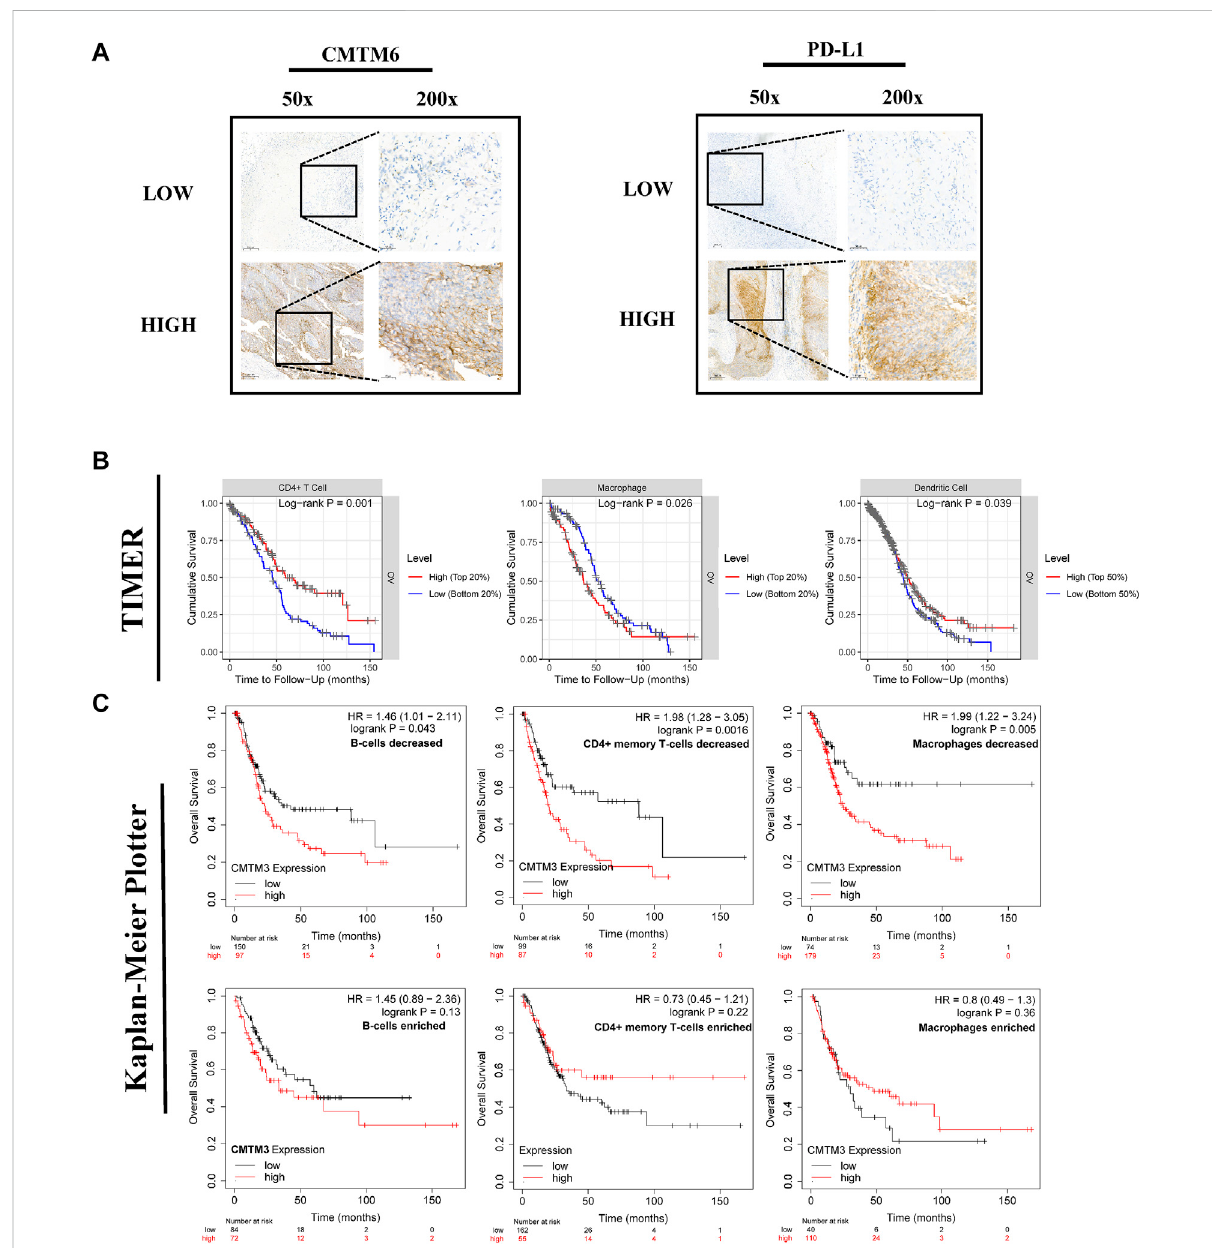
FIGURE 9 The immunohistochemical images of CD274 (PD-L1) and CMTM6, including 50x and 200x, respectively. The effect of CMTM3 expression level under different immune cell in fi ltration or different immune cell in fi ltration on the prognosis of patients with ovarian cancer. (A) The immunohistochemical images of CD274 (PD-L1) and CMTM6, including 50x and 200x, respectively. (HIGH represents the high-expression group of the CMTM6 gene; LOW represents the low-expression group of the CMTM gene) (B) Survival curves of different levels of immune cell in fi ltration, including dendriticcells, CD4 + cells, and macrophages. (C) Survival curves of the expression level of CMTM3under different immune cell in fi ltrations, including B cells, CD4 + cells, and macrophages. The logrank p value, HR (hazard ratio), and 95% con fi dence interval were recorded. p value of < 0.05 was considered statistically signi fi